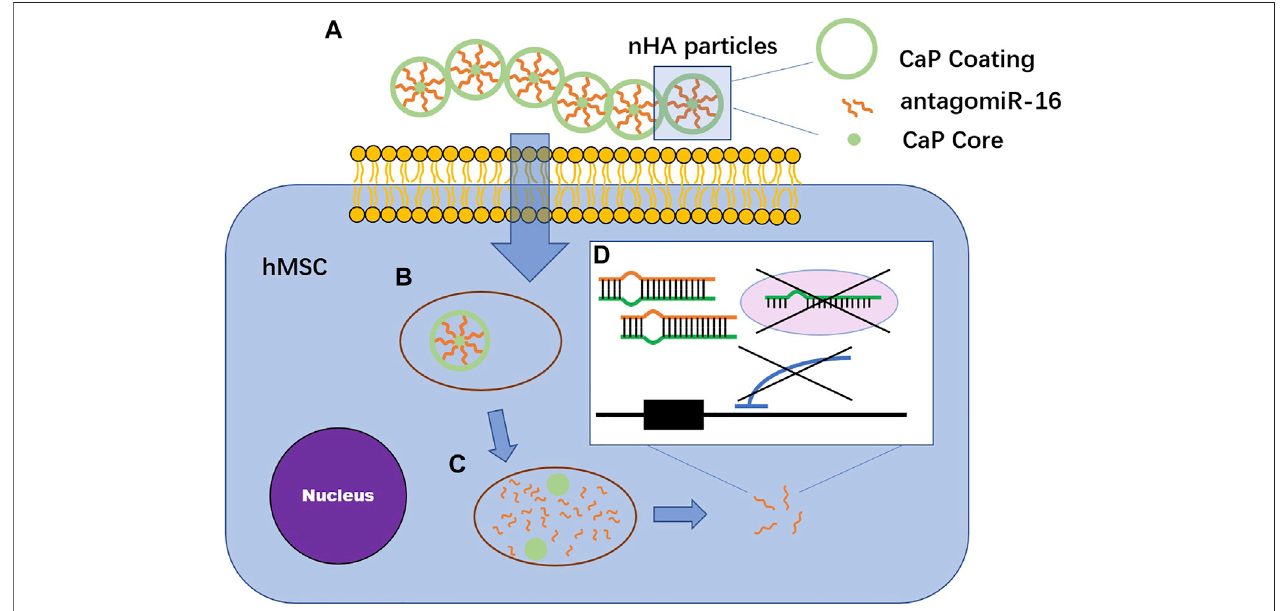
FIGURE3 | Themechanism ofcalcium phosphates vectors transfecting antagomiR-16. (A) AntagomiR-16 binds tonHA particles through electrostaticinteraction between Ca 2+ in CaP vector and phosphate groups in miRNA structure. The complex are found in multiparticulate formations. (B) nHA-antagomiR-16 particles pass throughlipidbilayercellmembranesalongendocytosis. (C) AntagomiR-16undergoesendosomalescapebeforethefusionofendosomewithlysosome. (D) AntagomiR speci fi cally complement to their mature target miRNA, inducing the repression of miRNA, preventing translation repression or Smad5 and AcvR2a mRNA degradation via RISC.